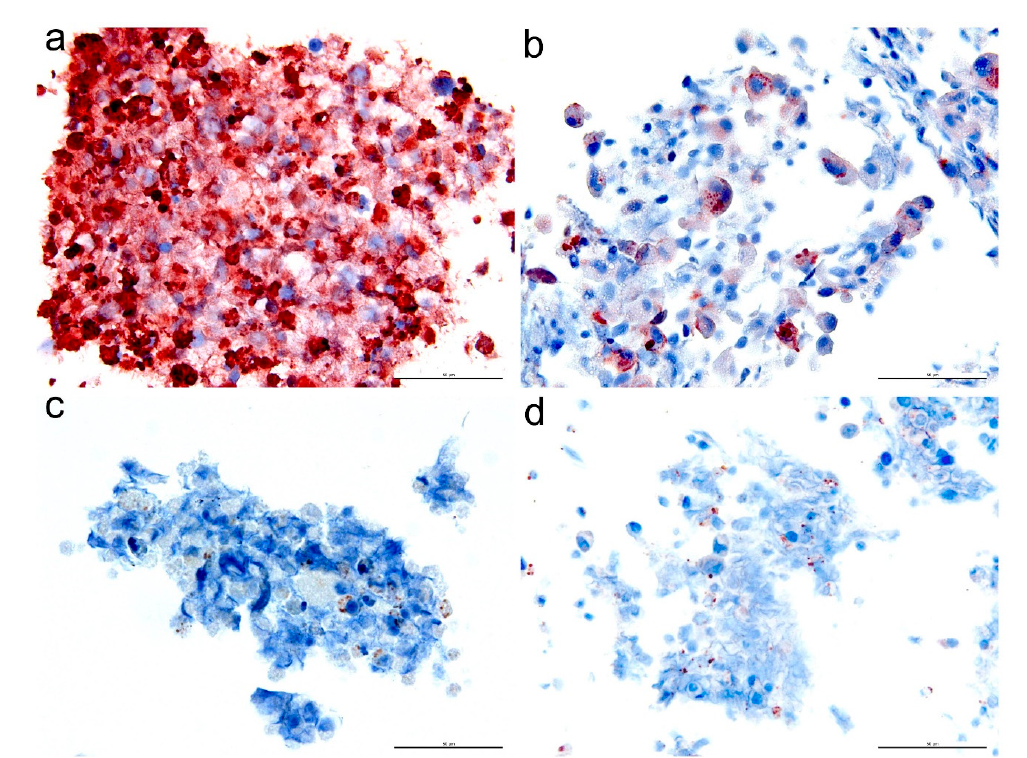
Figure 4. Immunolabelling of BHK-BSR cells infected with other orbiviruses using BTV NS2-specific mAb 465. Epizootic haemorrhagic disease virus (EHDV) ( a ), Eubenangee ( b ), Wallal ( c ), and Warrego virus ( d ). Bar = 50 μ m.